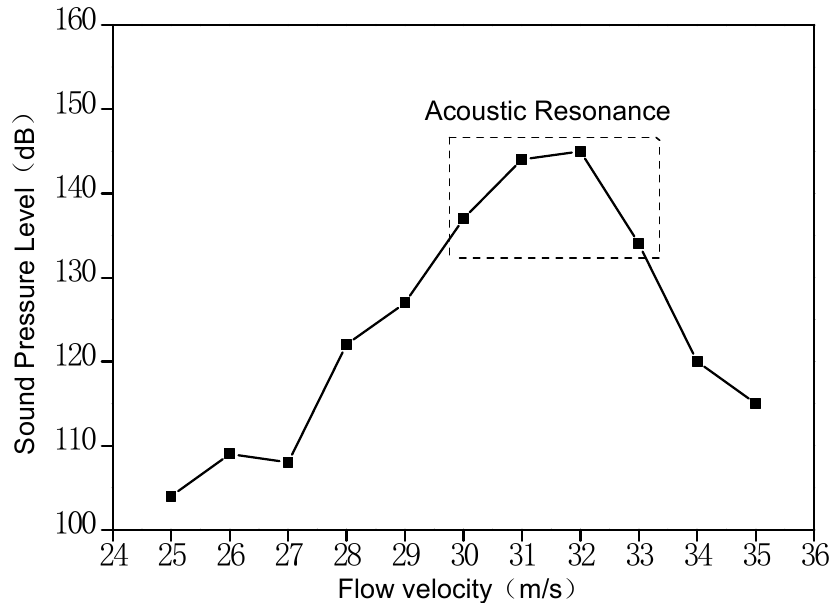
Figure 14. Variation law of sound pressure frequency under different flow velocities.